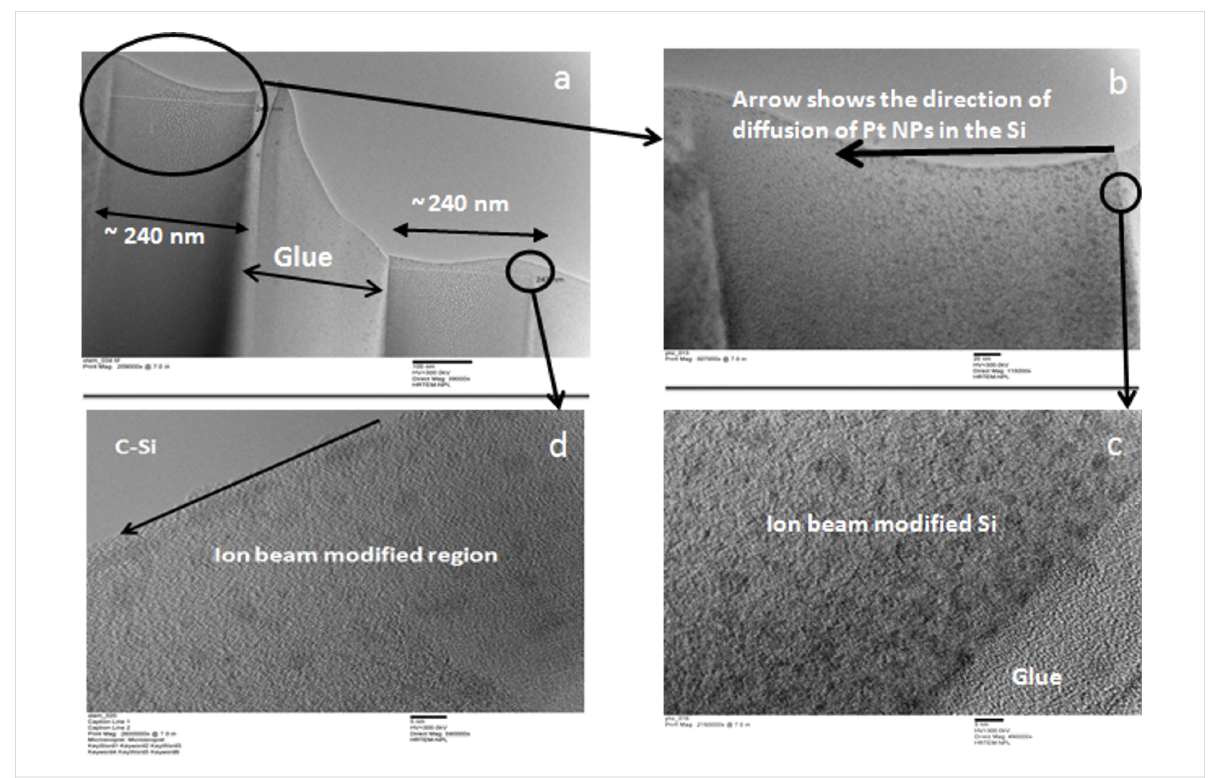
Figure 5: TEM images a) various interfaces, b) density distribution of NPs in ion beam modified region, c) interface showing high density of NPs near surface and absence of Pt on the surface, and d) NP distribution near the end of collision cascade.